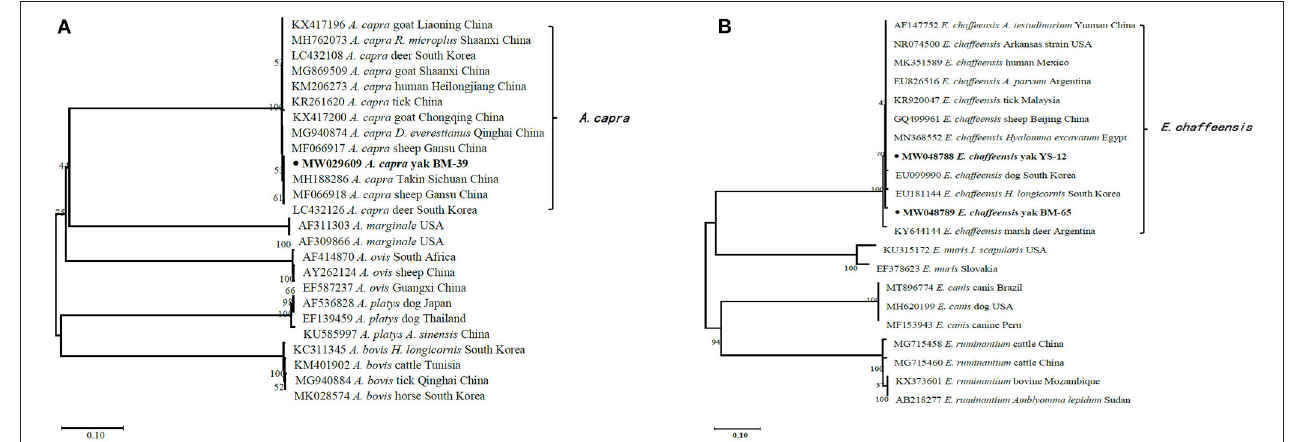
FIGURE 3 | Phylogenetic trees were constructed based on partial sequences of the 16S rRNA genes of A. capra (A) and E. chaffeensis (B) . Phylogenetic trees were constructed by the neighbor-joining method with the p-distance model using the MEGA X software, and the bootstrap test was assessed with 1,000 replicates. The species identified in this study are indicated by • and highlighted in